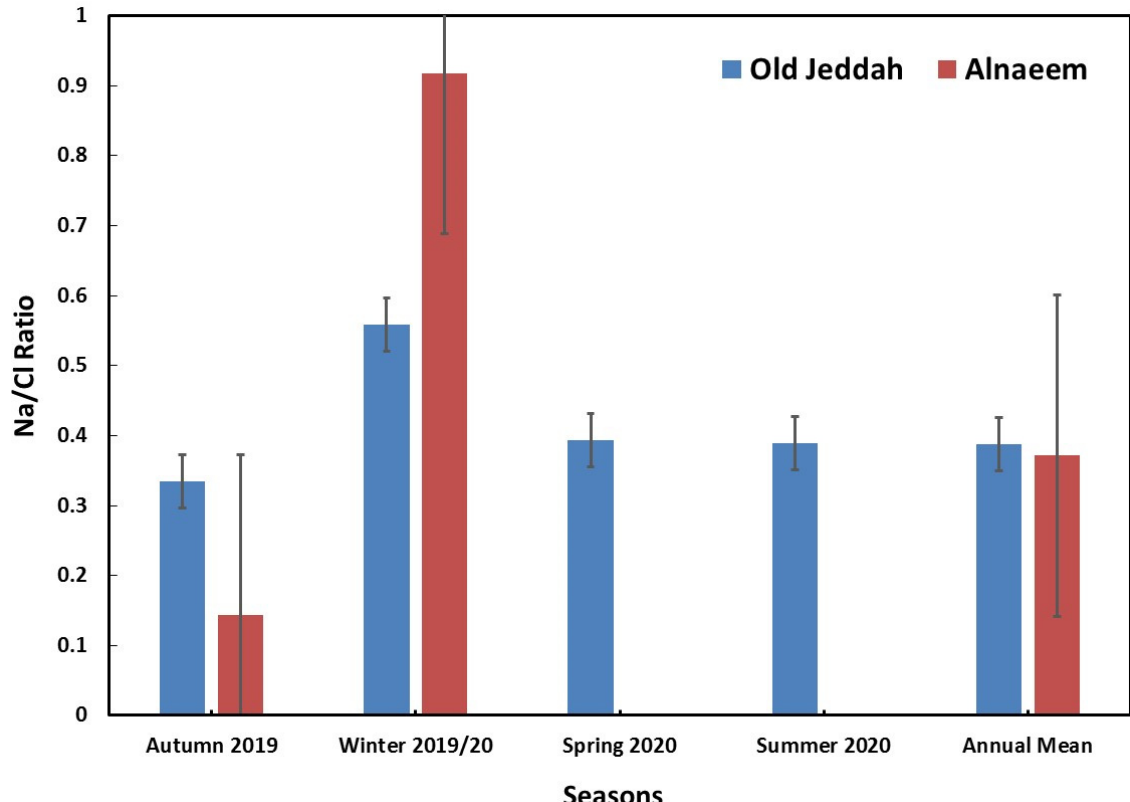
Figure 8. The Na/Cl ratios at historical Jeddah and Alnaeem districts versus the seasons of the year as well as the overall average values.